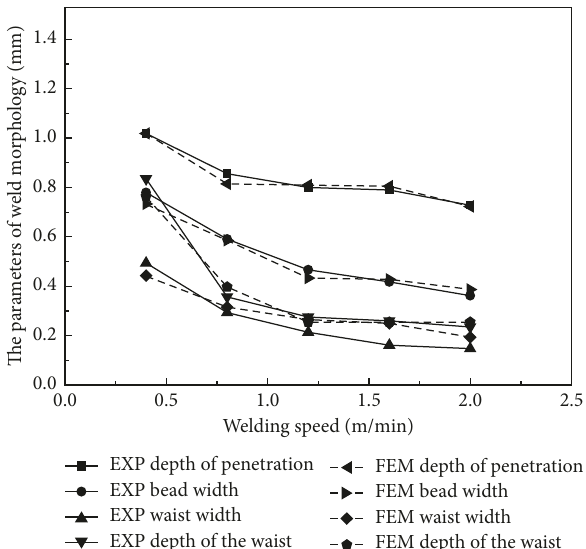
Figure 11: Comparison of experimental and simulation results for the depth of penetration, bead width, waist width, and depth of the waist for different welding Table 5: Simulation error of six heat source modes about laser welding of the stainless steel sheet. Heat source mode Waist Conical and inverted conical [10] Conical [11] Double ellipsoid and conical [11] Conical and cylindrical [11] Conical, inverted conical, and ellipsoid [12] Cylindrical and cylindrical Minimum simulation error.